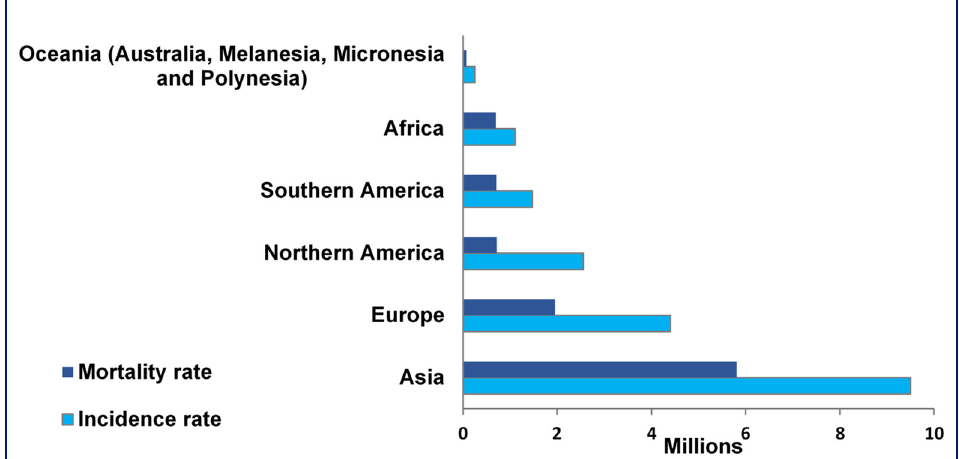
Figure 1. Mortality and incidence rates of cancer cases at ages <70 years in 2020. Adapted from [20].